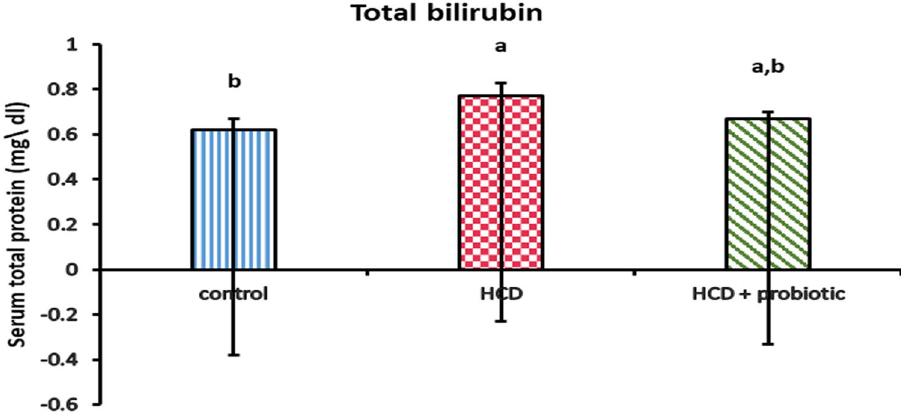
Figure 12. Effect of HCD supplementation and HCD with probiotic on liver function (Total bilirubin).